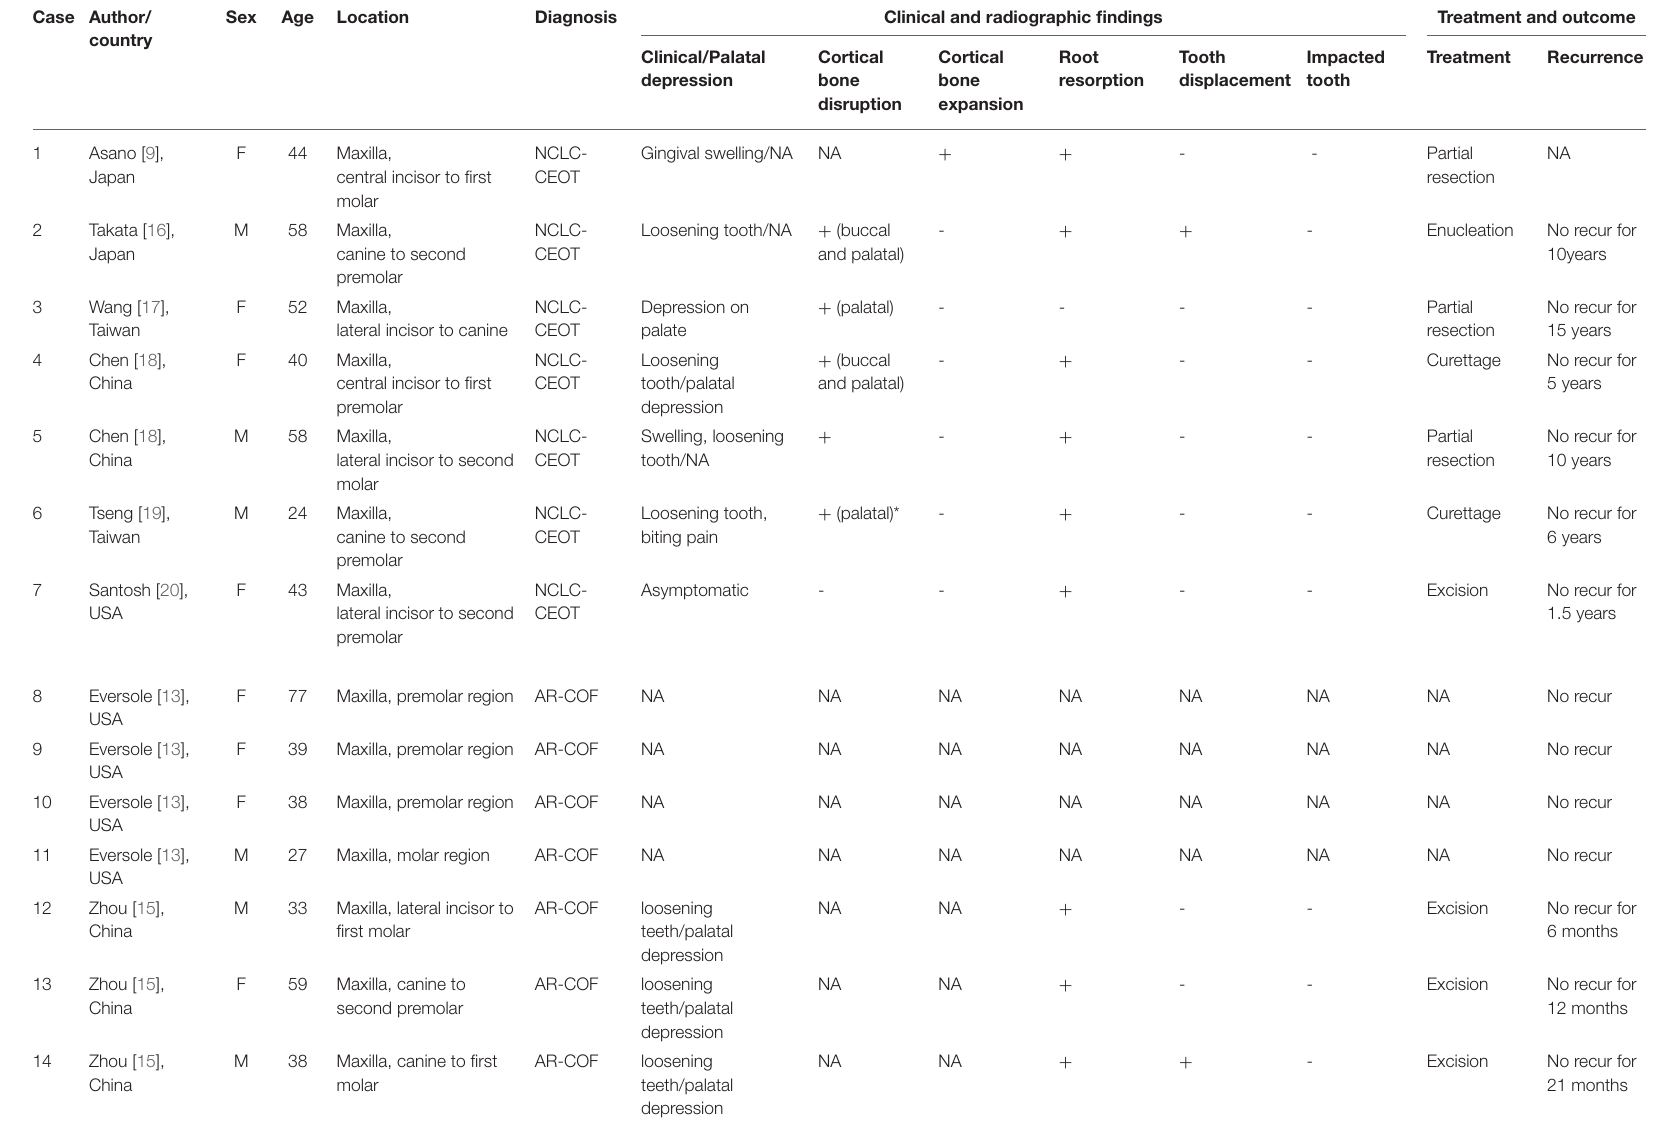
TABLE 1 | Clinical findings in 7 non-calcifying, Langerhans cell rich calcifying epithelial odontogenic tumor (NCLC-CEOT) as well as 21 amyloid rich variant of central odontogenic fibroma